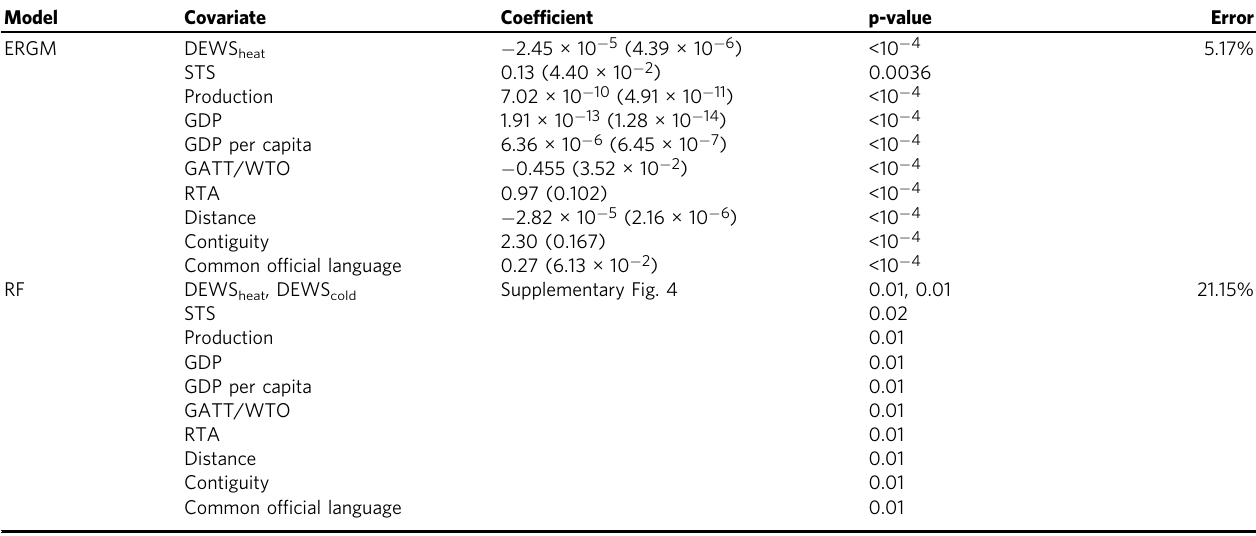
Table 1 Summaries of the models for 2005 – 2014 unweighted directed (trade presence) international wheat trade network. Model ERGM